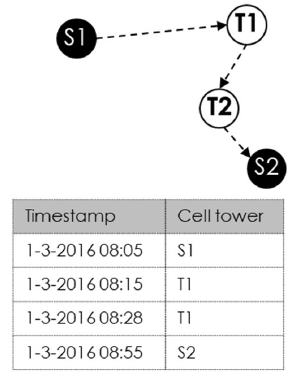
Figure 10. Example of an extracted trip from a CDR.